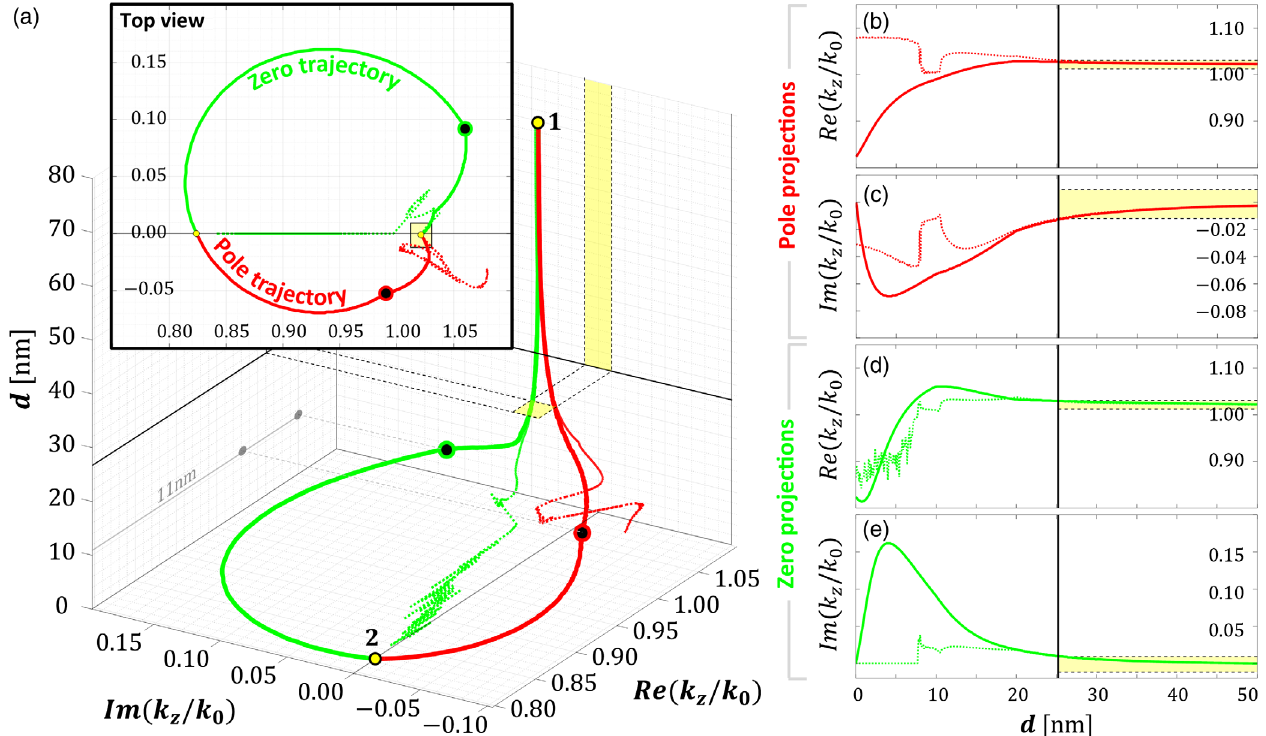
FIG. 10. Comparison of the exact and Fano fitted dispersion. (a) The exact (solid curves) and fitted (dotted curves) values of the reflection pole (red) and zero (green) complex wave vectors as a function of gold film thickness d at illumination wavelength λ ¼ 800 nm. Inset: A top view showing their closed-loop trajectory (yellow points 1 → 2 ). (b) – (e) Projections of the pole and zero wave vectors in (a) over the real and imaginary axes separately. The narrow wave-vector region in which the generalized Fano line shape fits the exact calculated reflectance with a reasonable coefficient of determination ( R 2 > 0 . 7 ) is highlighted in yellow, corresponding to films thicker than 25 nm (solid black line). The maximally split momentum state of the pole and zero that gives rise to wideband absorption is highlighted by black dots (11 nm) and lies outside of this